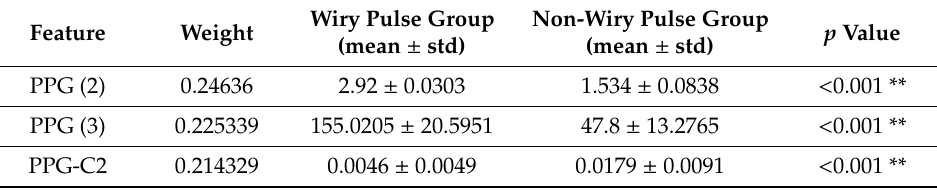
Table 3. Order of importance of